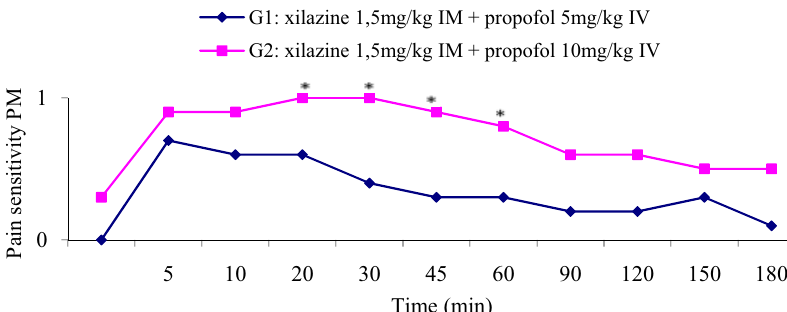
FIGURE 1 – Average scores of pain sensitivity in the pelvic members (PM) at different times, in P. expansa anesthetized with 1.5 mg/kg IM of xylazine and 5 mg/kg IV of propofol, and with 1.5 mg/kg IM of xylazine and 10 mg/kg IV of propofol. The asterisks (*) indicate significant differences between the groups (p < 0.05)